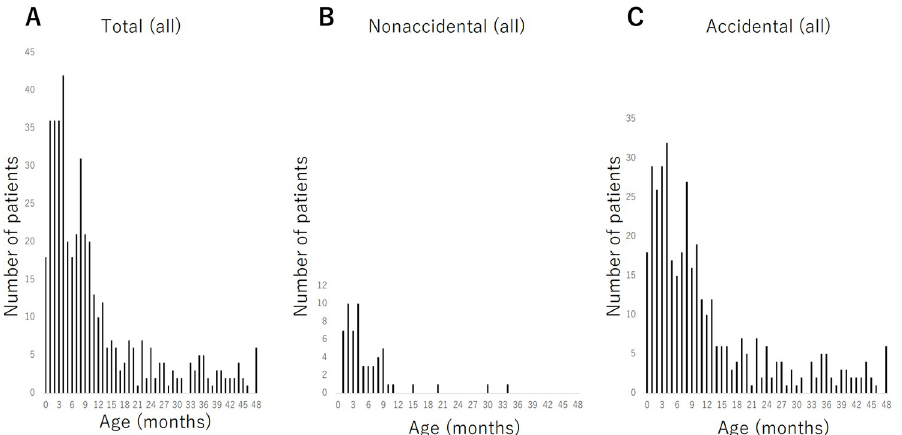
Fig 1. Age distribution of all patients in this study. A: Total, B: Nonaccidental, C: Accidental.